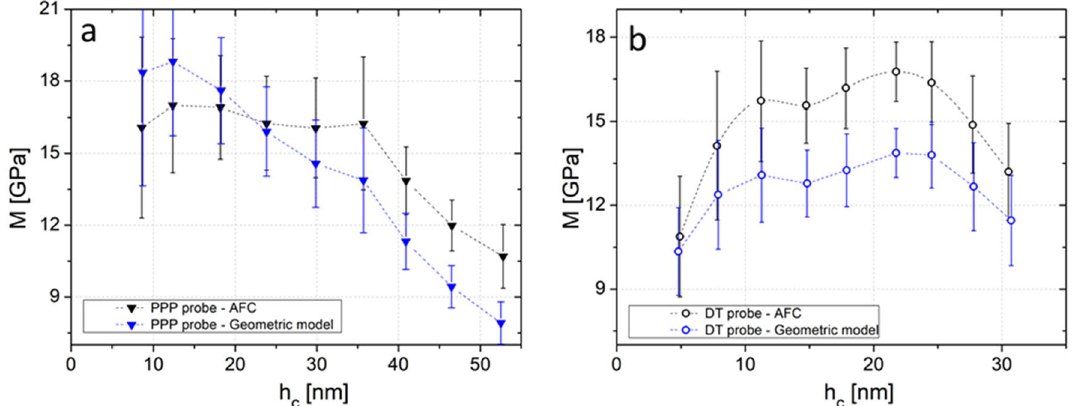
Figure 3. Indentation modulus as a function of indendation depth for: ( a ) PPP probe, ( b ) DT probe on tension wood G layer. Indentation modulus is computed using the area function calibration (AFC) (black) or using spherical-conical geometric model (blue). The dash-dotted lines are guide for the eye. Error bars are standard deviation, n =